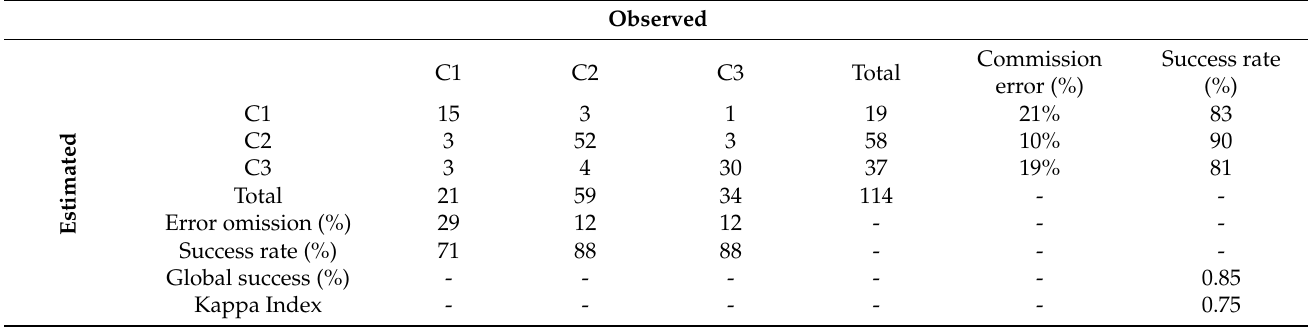
Table 4. Confusion matrix results; C1—weakly metamorphosed, C2—moderately metamorphosed, C3—strongly meta-